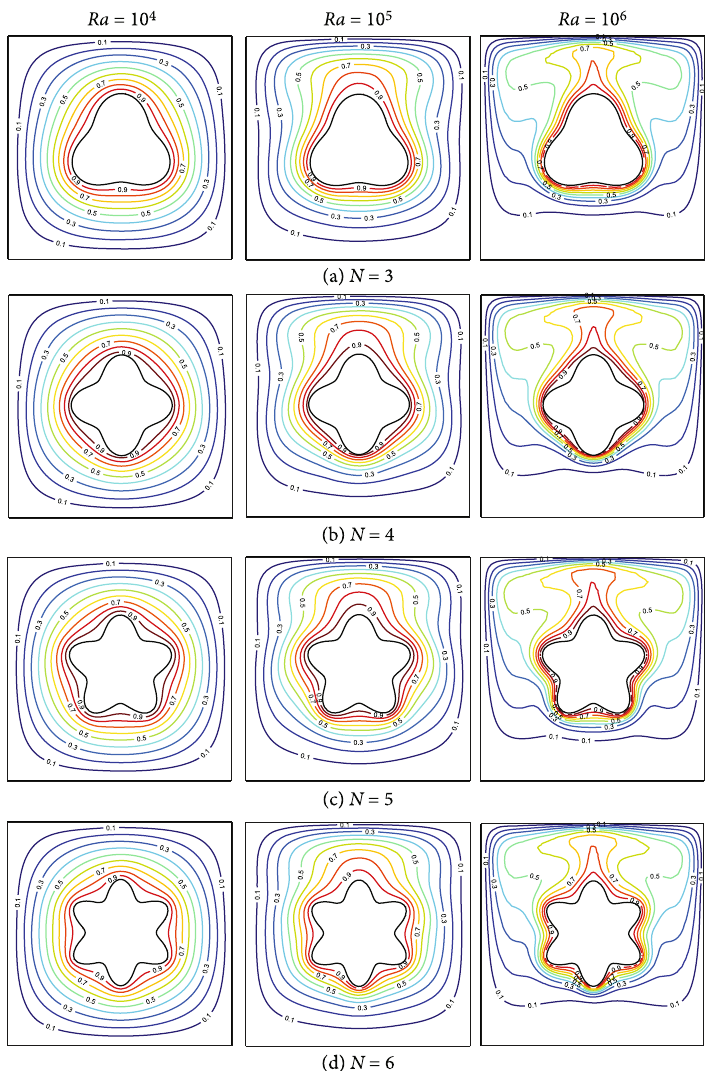
Figure 6: Isotherms for di ff erent Rayleigh numbers and varying the undulation number, N at A = 0 : 2 and ϕ = 0 : 03